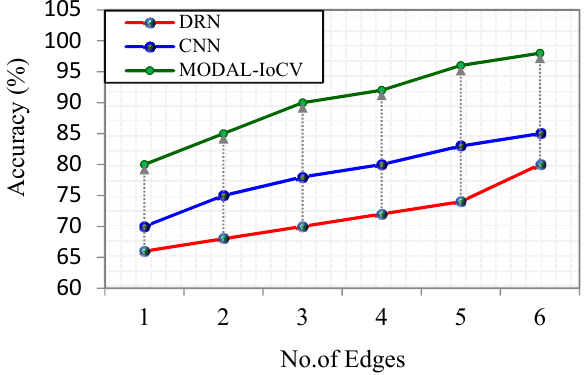
Figure 10. Number of edges vs. accuracy.